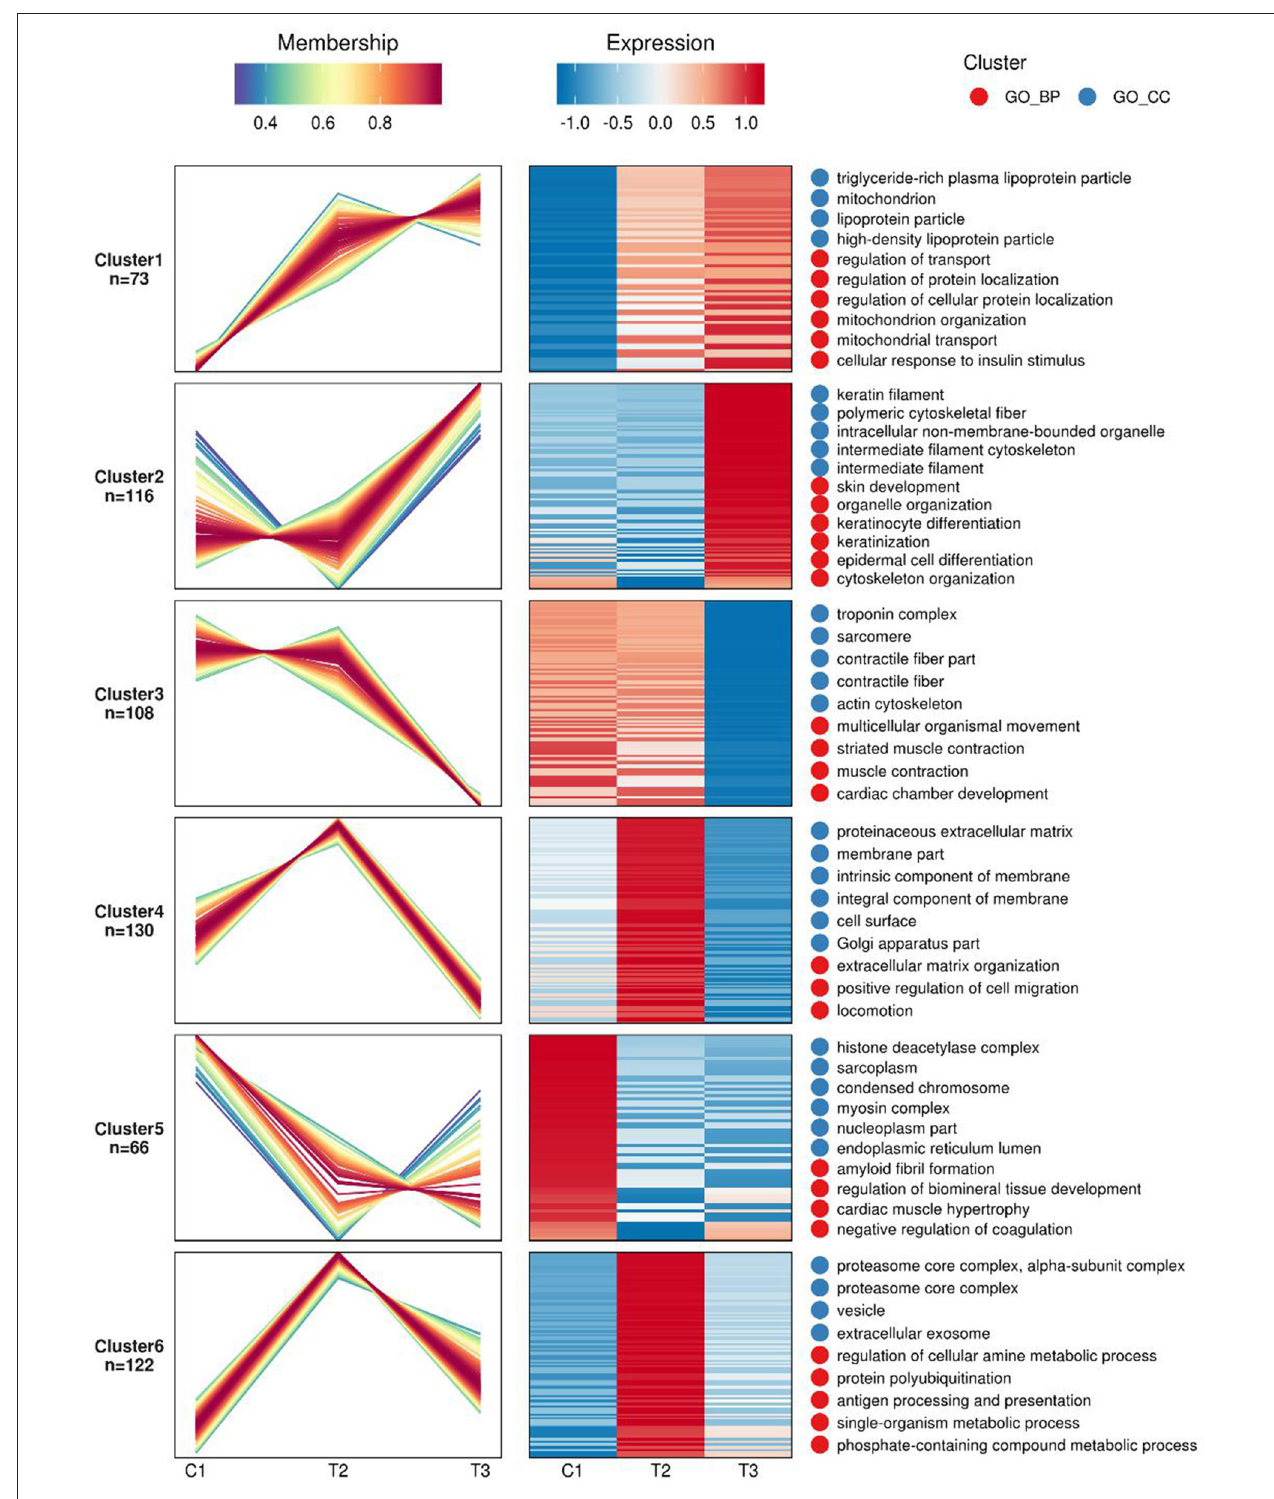
FIGURE 1 | Mfuzz analysis of differential proteins expression in the studied three groups of atherosclerotic patients: The shade of red and blue represents high expression and low expression, respectively.C1 demotes the control group, T2 is the SCAD group, while the T3 is the AMI group.